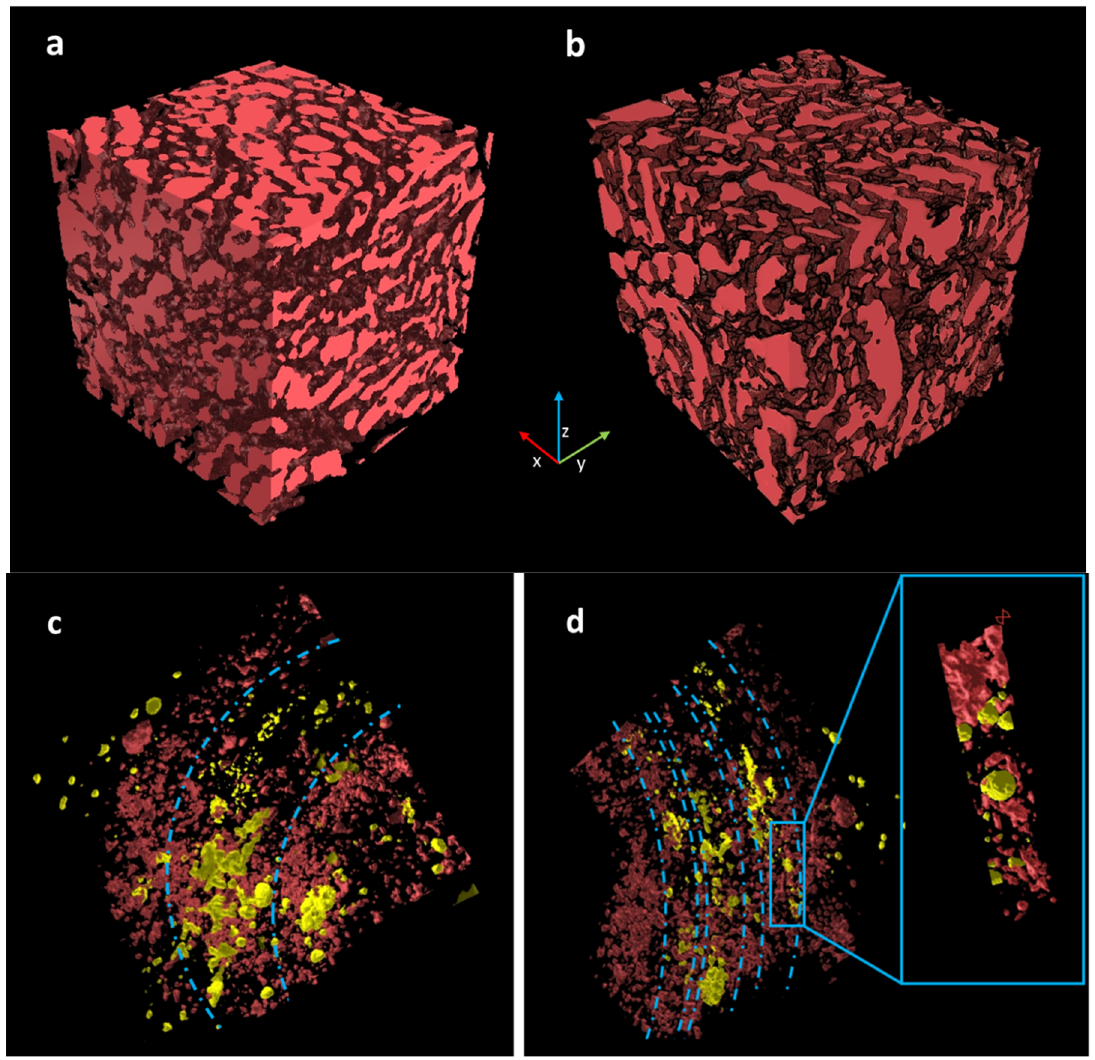
Figure 6. Three-dimensional images of the vasculature of ex vivo GBM samples. Three-dimensional volume (350 × 350 × 350 µm 3 ) of GBM samples treated ( a ) only with the optical radiation dose (control) and ( b ) after intratumoral injection of Ir 1 followed by light exposure. The microvasculature is rendered in red. The tissues were computationally removed from the three-dimensional rendering to highlight the vessel’s distribution. ( c , d ) Three-dimensional volume (350 × 350 × 350 µ m 3 ) of GBM sample after intratumoral injection of Ir 1 -AuSiO 2 followed by light exposure (top view). Vessels are rendered in red, and the Ir 1 -AuSiO 2 clusters in yellow. Clusterized nanostructures appear distributed along some vascular channels highlighted by blue dashed lines. The inset highlights the details of nanoparticle clusters in the vascular structure and how their distribution correlates with the devascularized structure, which appears to be reduced and